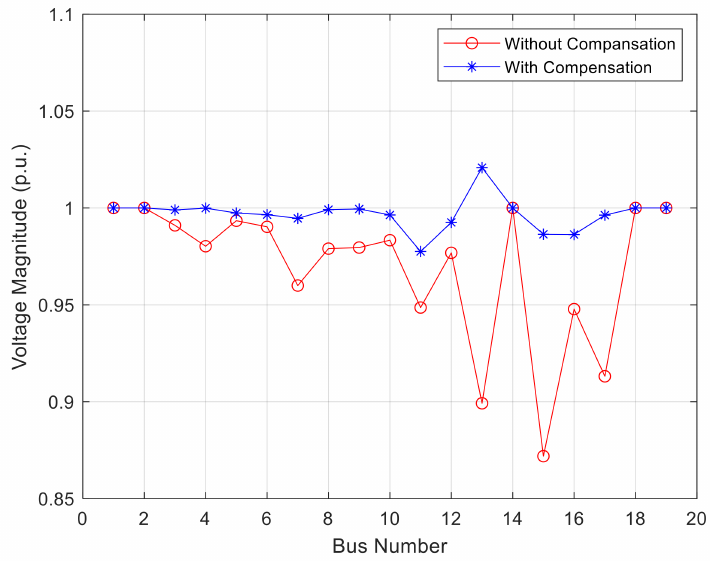
Figure 7. Comparison of voltage profile before and after case 3